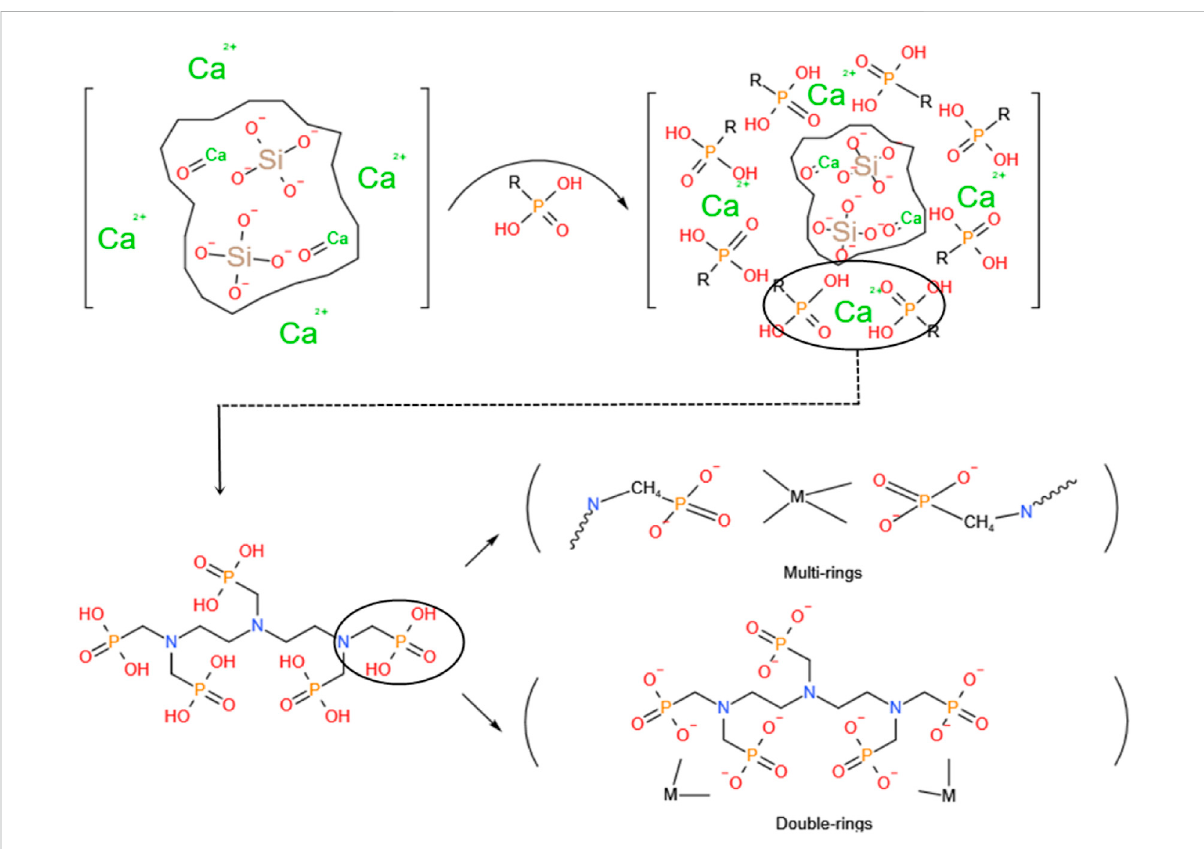
FIGURE 9 Schematic of the molecules in the complexation reaction and schematic of the molecules surrounded by the complexes on the surface of the single-ore particles without hydration reactions.